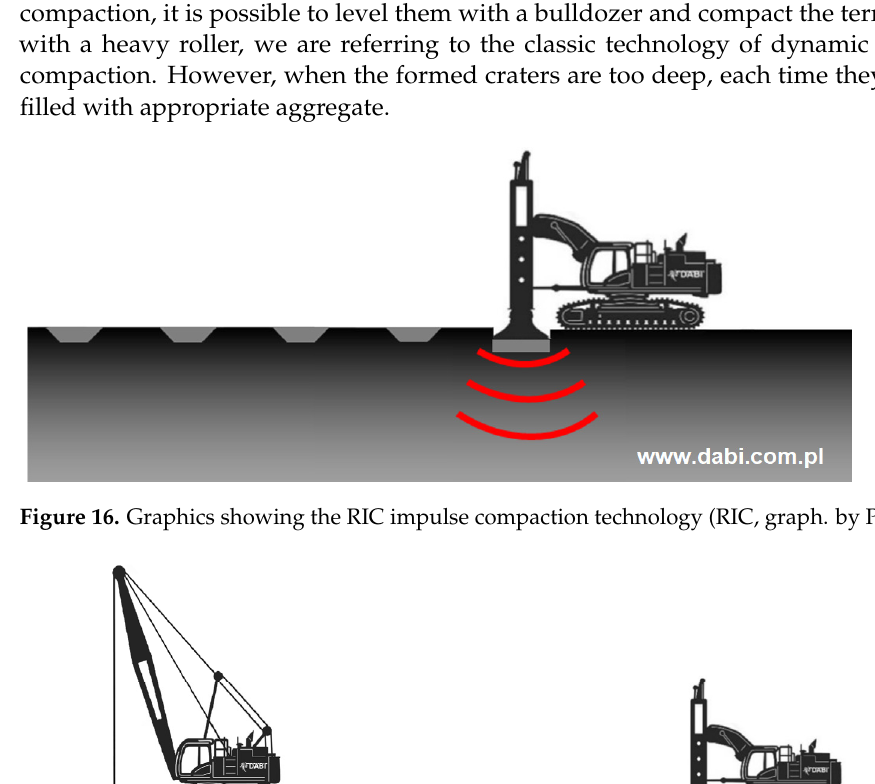
15 of 25 Figure 15. Graphics showing the technology of DC dynamic compaction (heavy compaction, graph. by P. Dobrzycki). In the case of more minor soil (waste) thickness that requires compaction, RIC (Rapid Impact Compaction) technology can be used instead of the above method. This method uses the same principle of soil compaction due to the energy of the compactor falling onto the ground. The difference is the falling height of the rammer, which is approximately 1.2